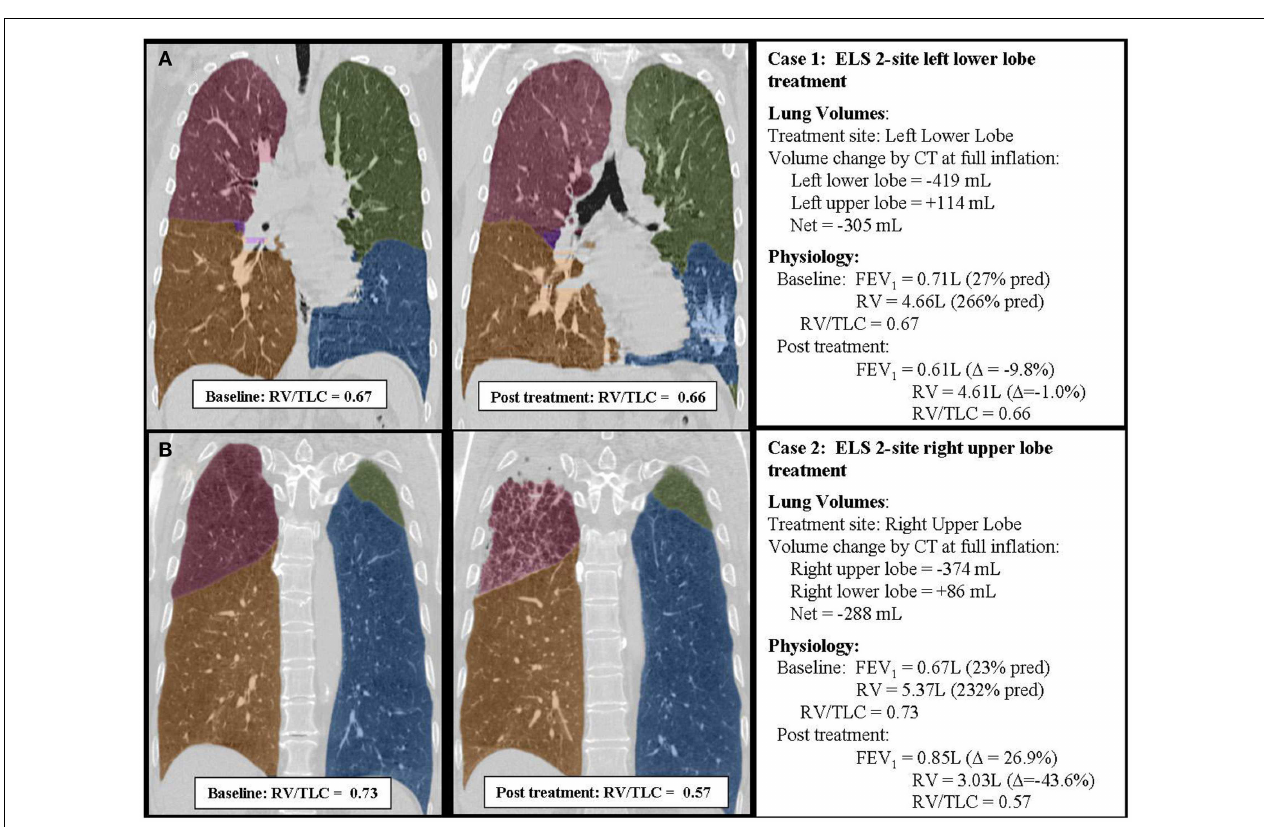
individual lobes have been shaded to better define lobar anatomy: the right upper lobe is shaded red, the right middle lobe purple, the right lower lobe yellow, the left upper lobe green, and the left lower lobe blue. Note that physiology was measured in the upright position while CT imaging was performed supine.The supine position is expected to alter gravitational effects on CT measurements of lobar volume by underestimating upper lobe volumes and overestimating lower lobe volumes by up to approximately